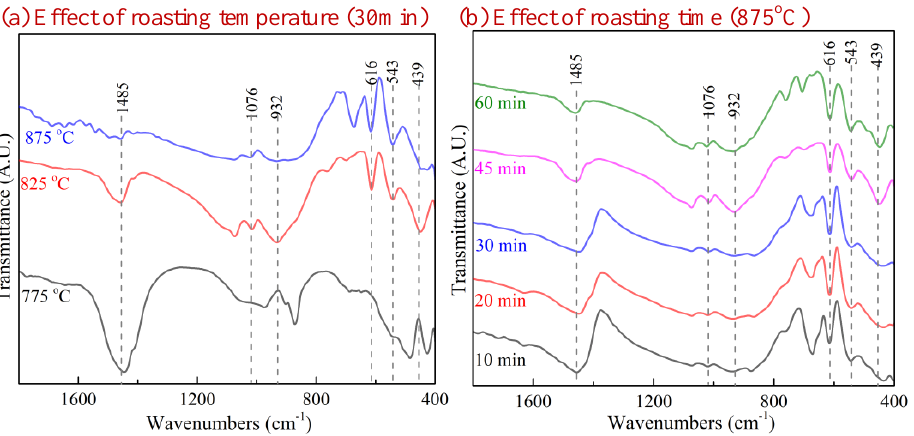
Figure 5. FTIR spectra of SnO 2 , SiO 2 and Na 2 CO 3 roasted products under 15 vol.% CO–CO 2 atmosphere.